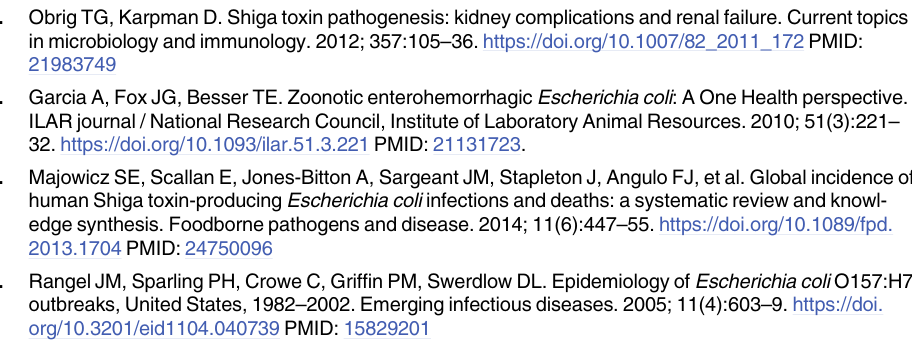
S6 Fig. BRIG plot comparing E . coli O157 strains 9000 and 10671. The genome of PT32 strain 10671 (red) was compared against reference PT21/28 strain 9000 (blue) for gene pres- ence/absence. Annotated prophage (grey) and their loci, including Stx2a F centred at 3,200 kbp, are shown for strain 9000. S1 Table. List of genes unique to E . coli O157 strains 9000 and 10671. S2 Table. Details of PCR primers used in this